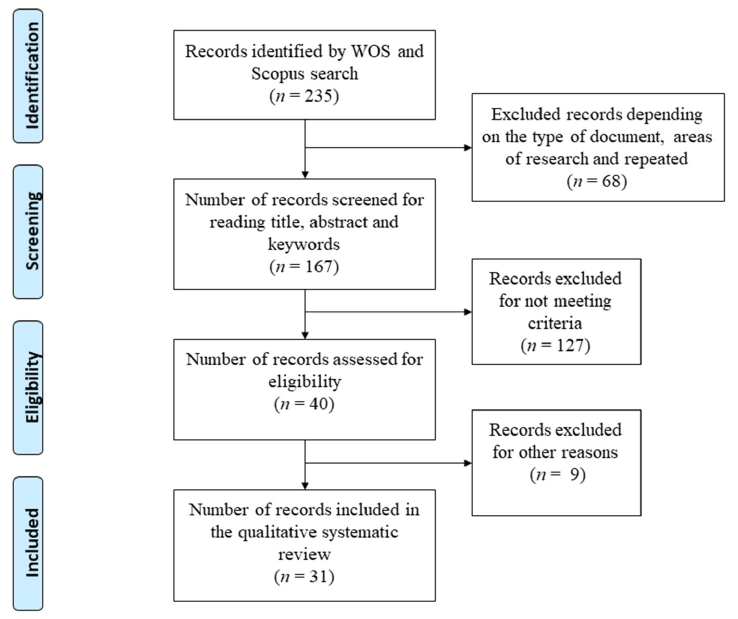
Figure 1. Flowchart of research paper selection.